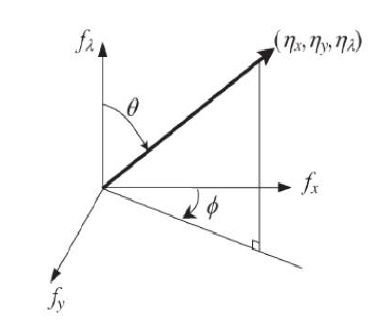
Figure 3. 3D Gabor filters orientation by 𝜃 ,